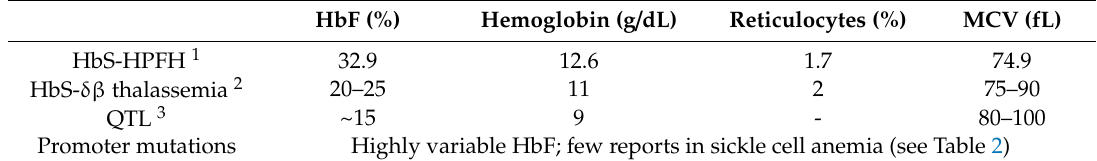
Table 1. Hematologic findings in sickle cell disease with unusually high fetal hemoglobin (HbF). HbF (%) Hemoglobin (g /